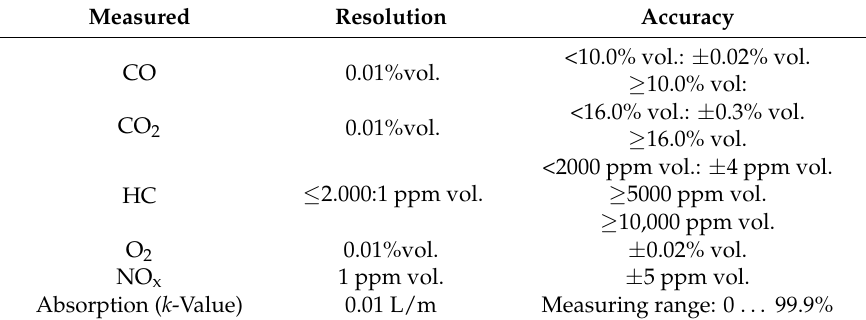
Table 3. The resolution and accuracies of the emission measurement sensors.